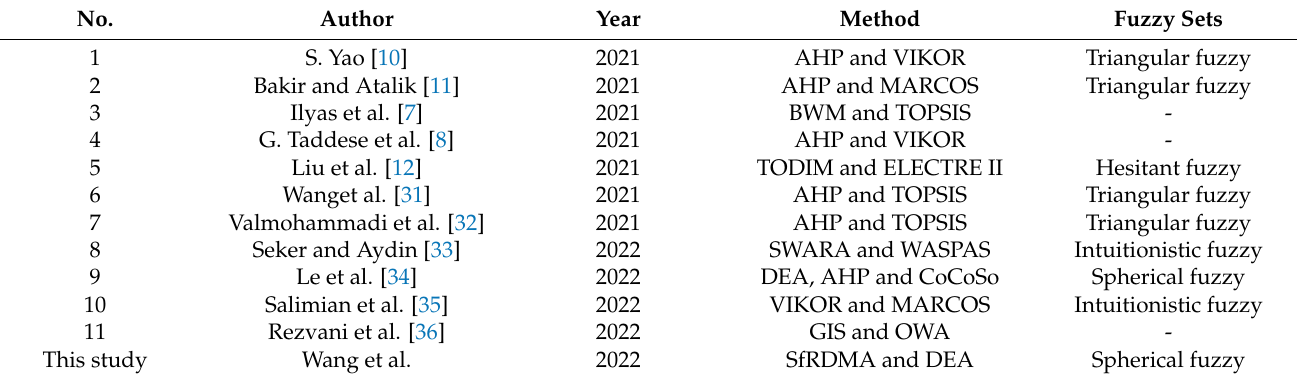
Table 1. Previous relevant